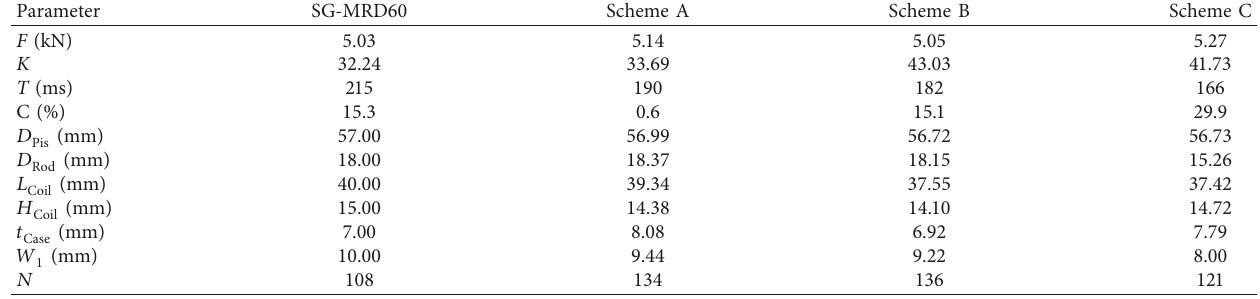
Table 5: Optimization results of partial geometry dimensions.